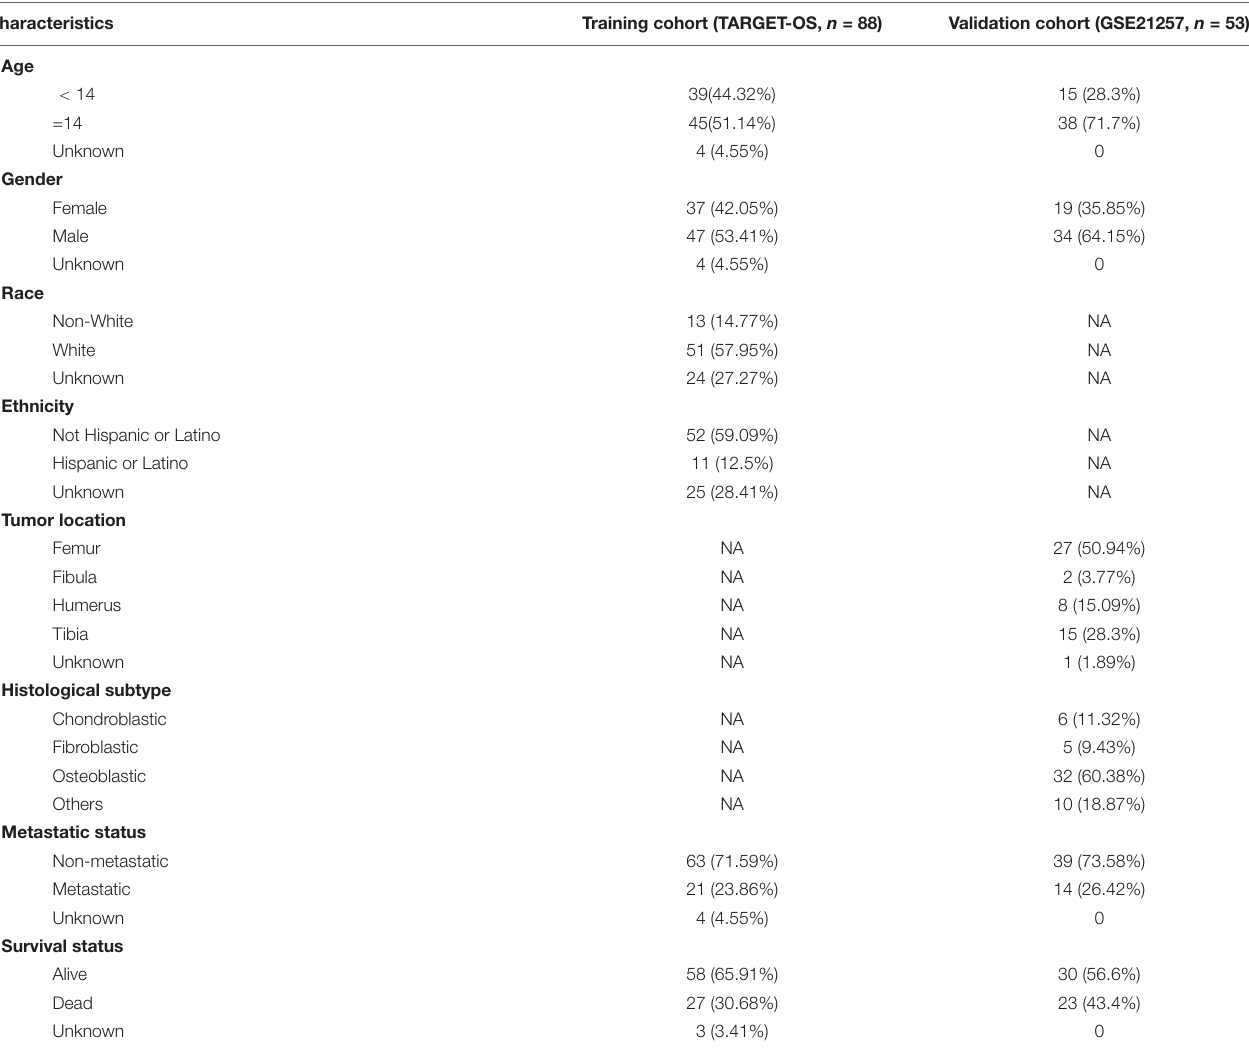
TABLE 1 | Clinical characteristics of patients involved in the study.